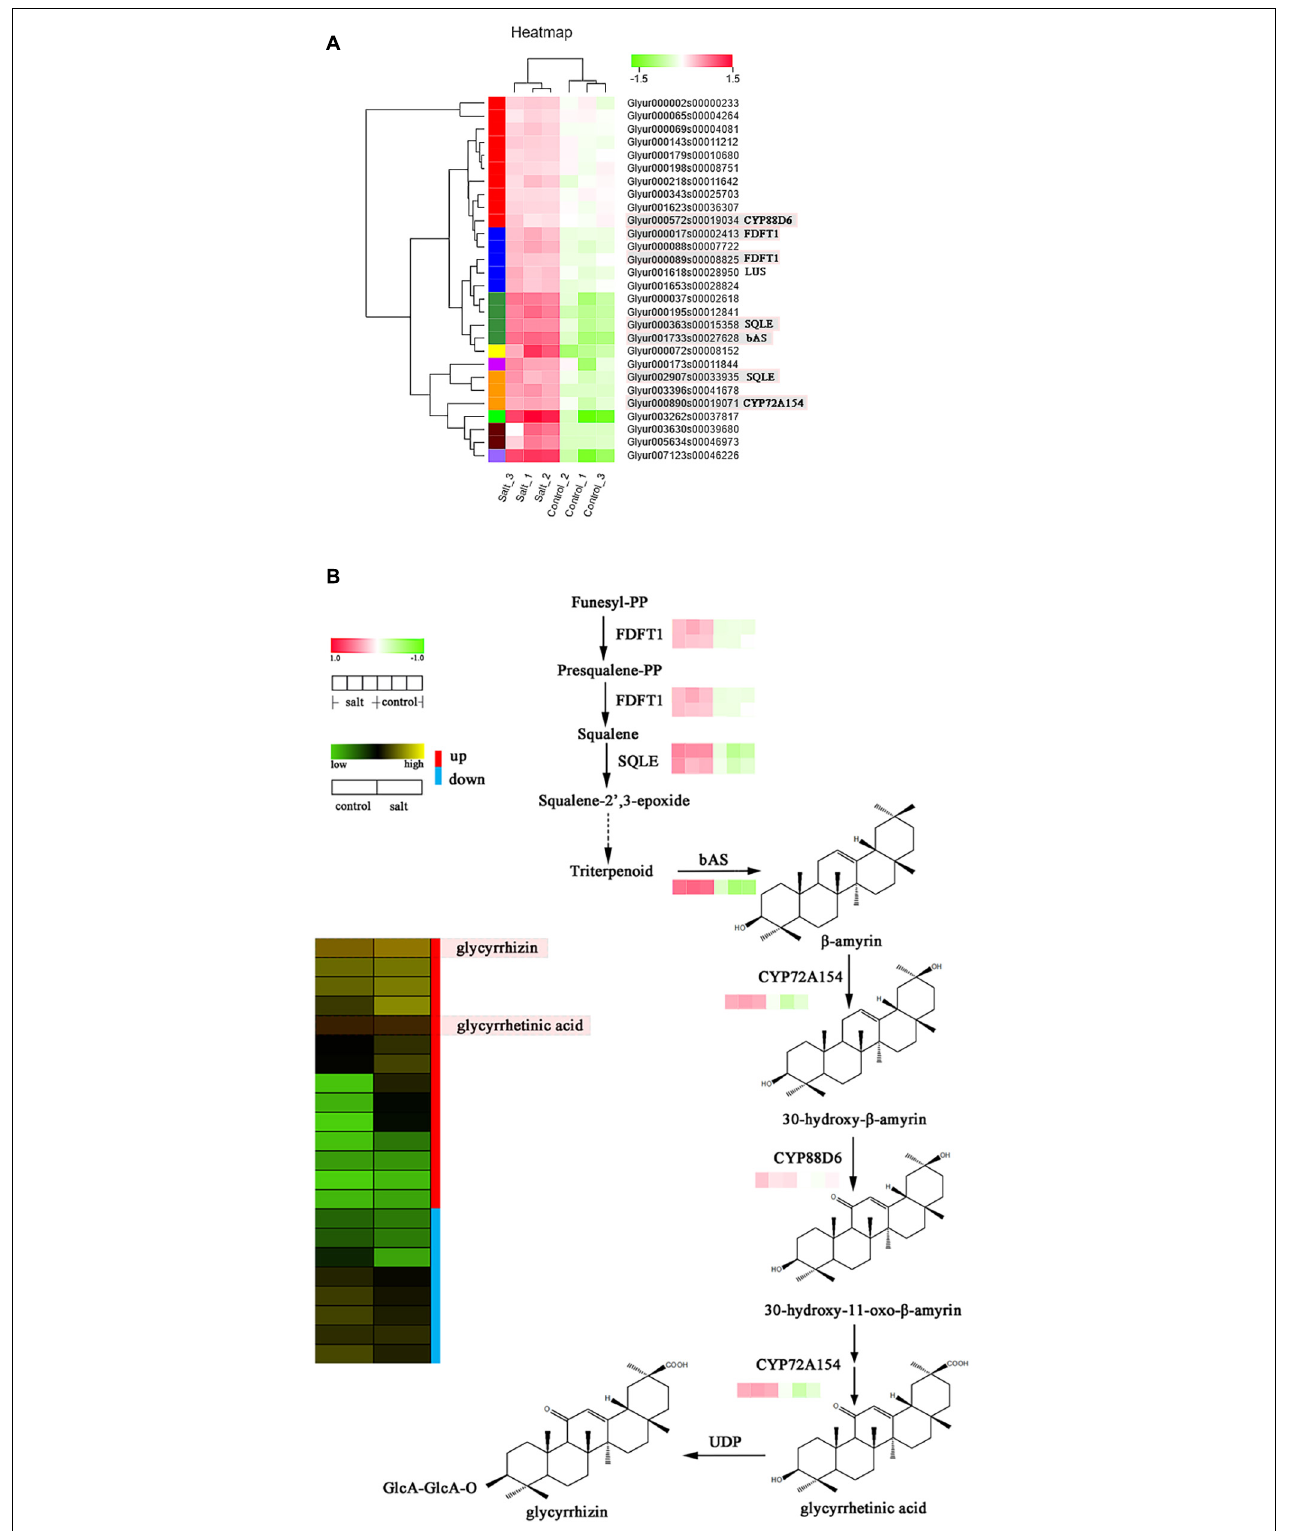
FIGURE 5 | (A) Expression levels of structural differentially expressed genes (DEG) involved in triterpenoid saponin biosynthesis. (B) Correlation analysis of expression patterns of key DEGs and metabolite profiles of triterpenoid saponins in licorice.